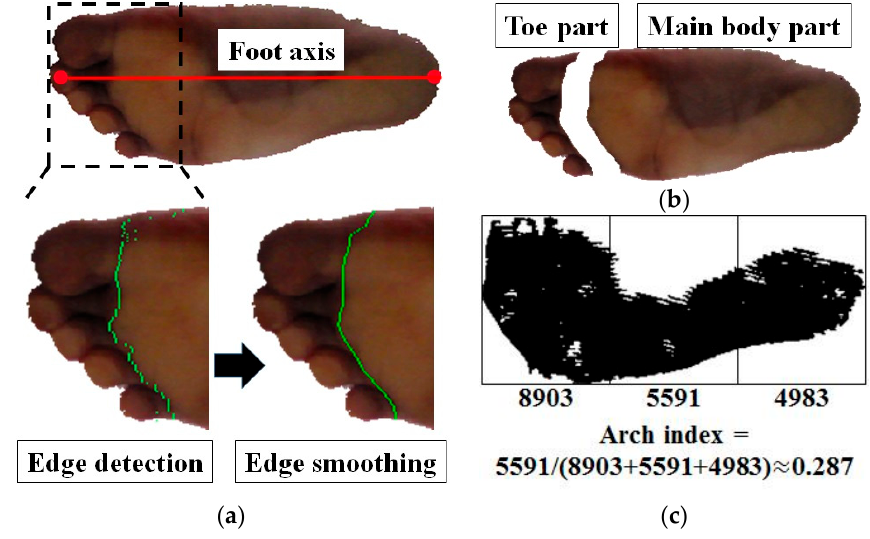
Figure 8. AI computation: ( a ) foot point image rotated by the foot axis (top) and the detected edge (colored green) (bottom), ( b ) toe part and main body part segmented by the edge, ( c ) result of AI computation from the segmented main body part of the contact region.